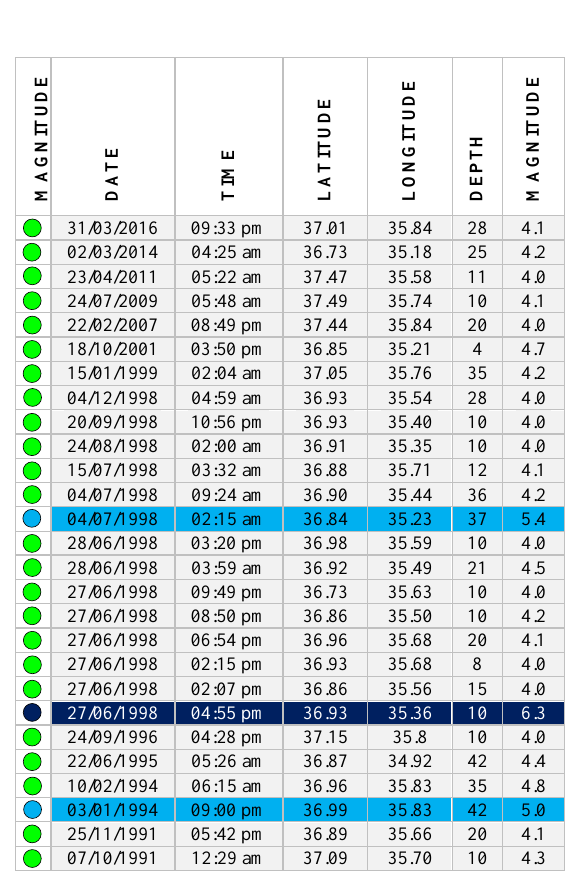
Figure 2. Location of earthquakes in the last two